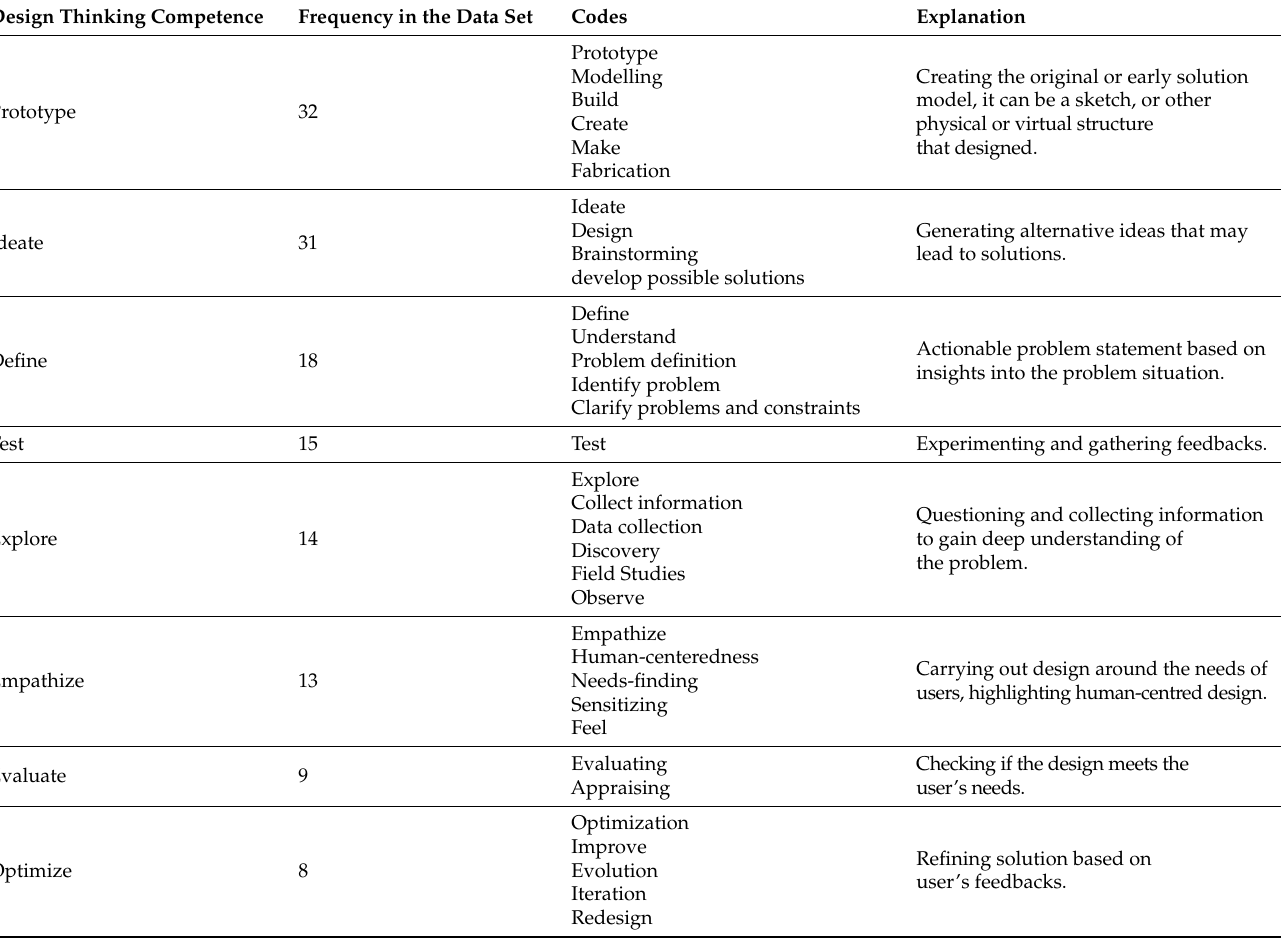
Table 2. The frequently mentioned design thinking competences among the empirical